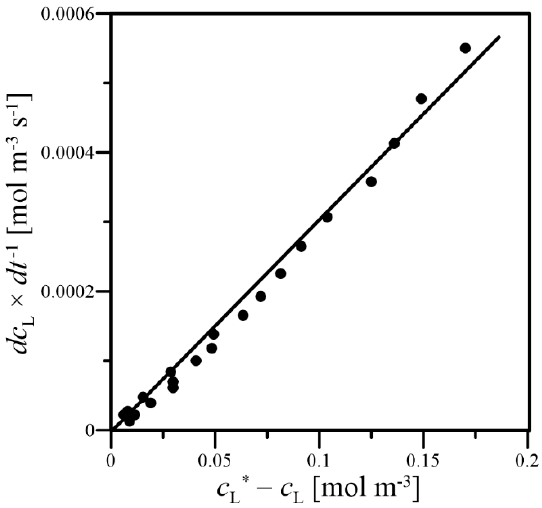
Figure 2. Graphical method for determination of the k L a coefficient.